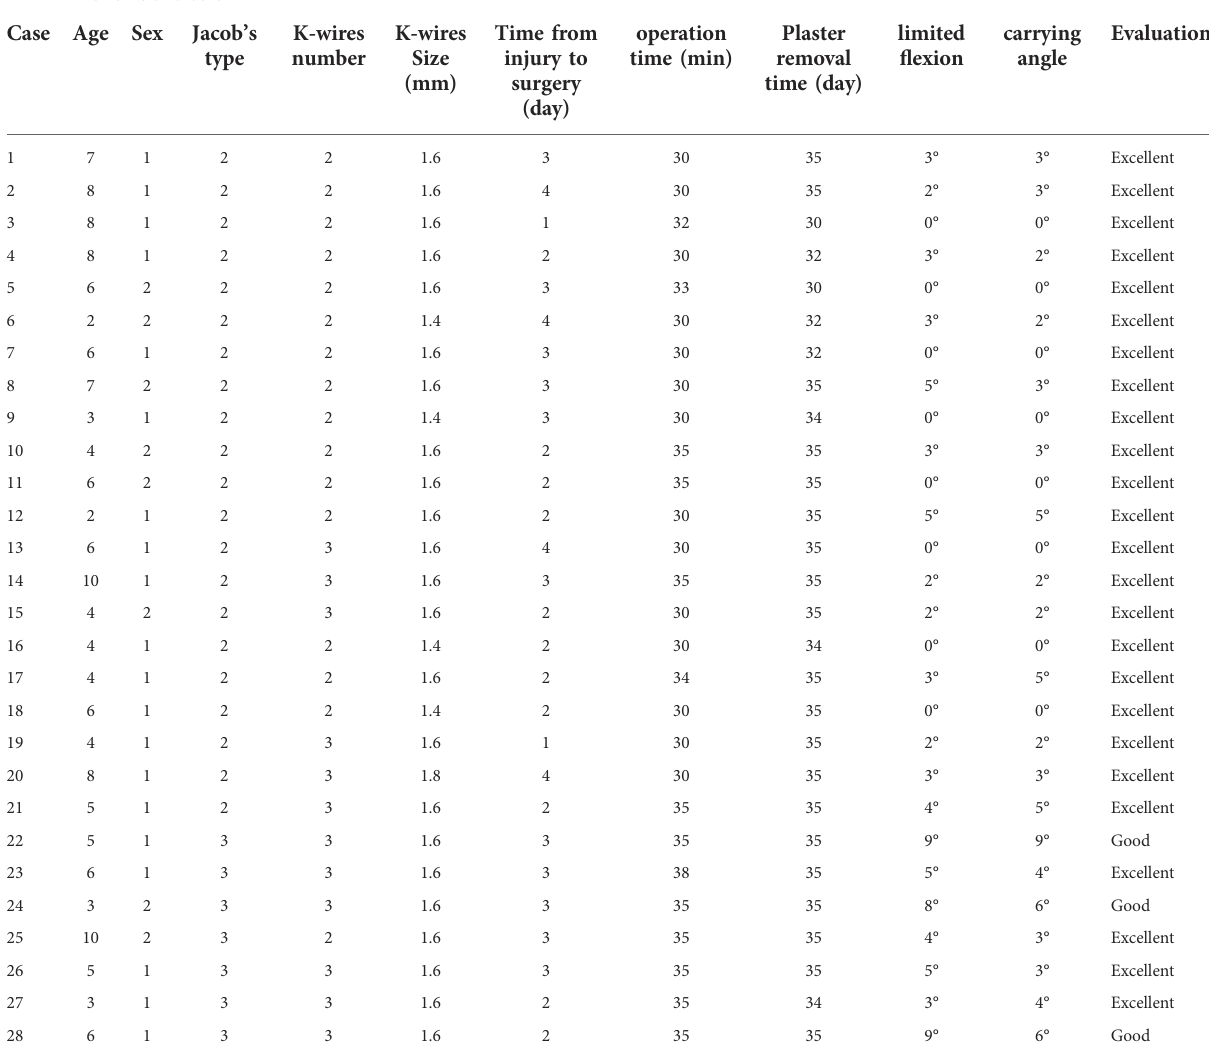
TABLE 1 Patients and